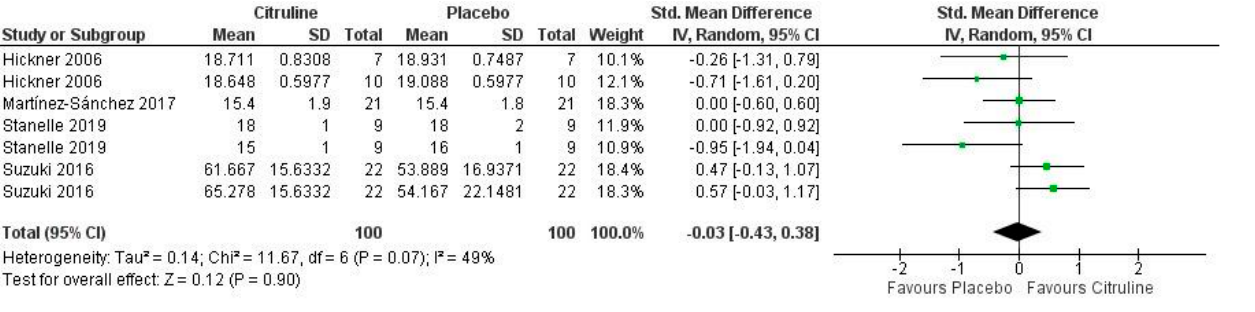
Figure 6. Forest plot comparative study of the effects of Cit supplementation on the RPE [43,49,59,60].